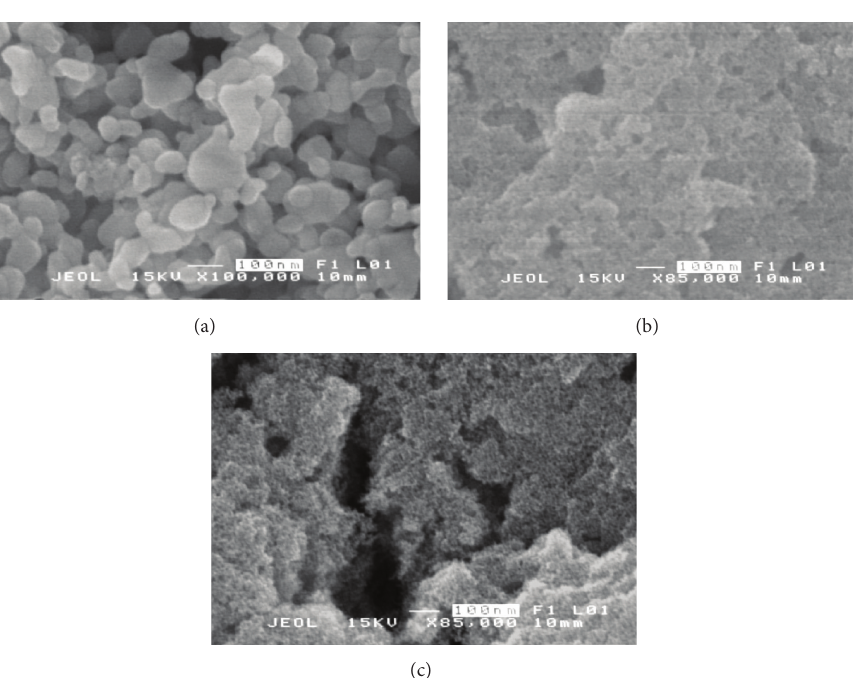
Figure 2: SEM images of (a) ZnO, (b) SnO 2 , and (c) SnO 2 /ZnO composite